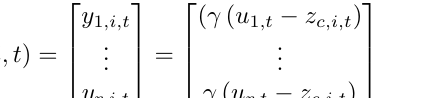
Figure 10: The input function θ t = µ Θ + v θ,t (upper panel), and the model output ˆ¯ y t for G cc = 0 (magenta), G cc = 0 . 5 (green) and G cc = 1 (blue). The green curve is also the output ¯ y t from the assumed evolutionary system (35) to (37) itself.